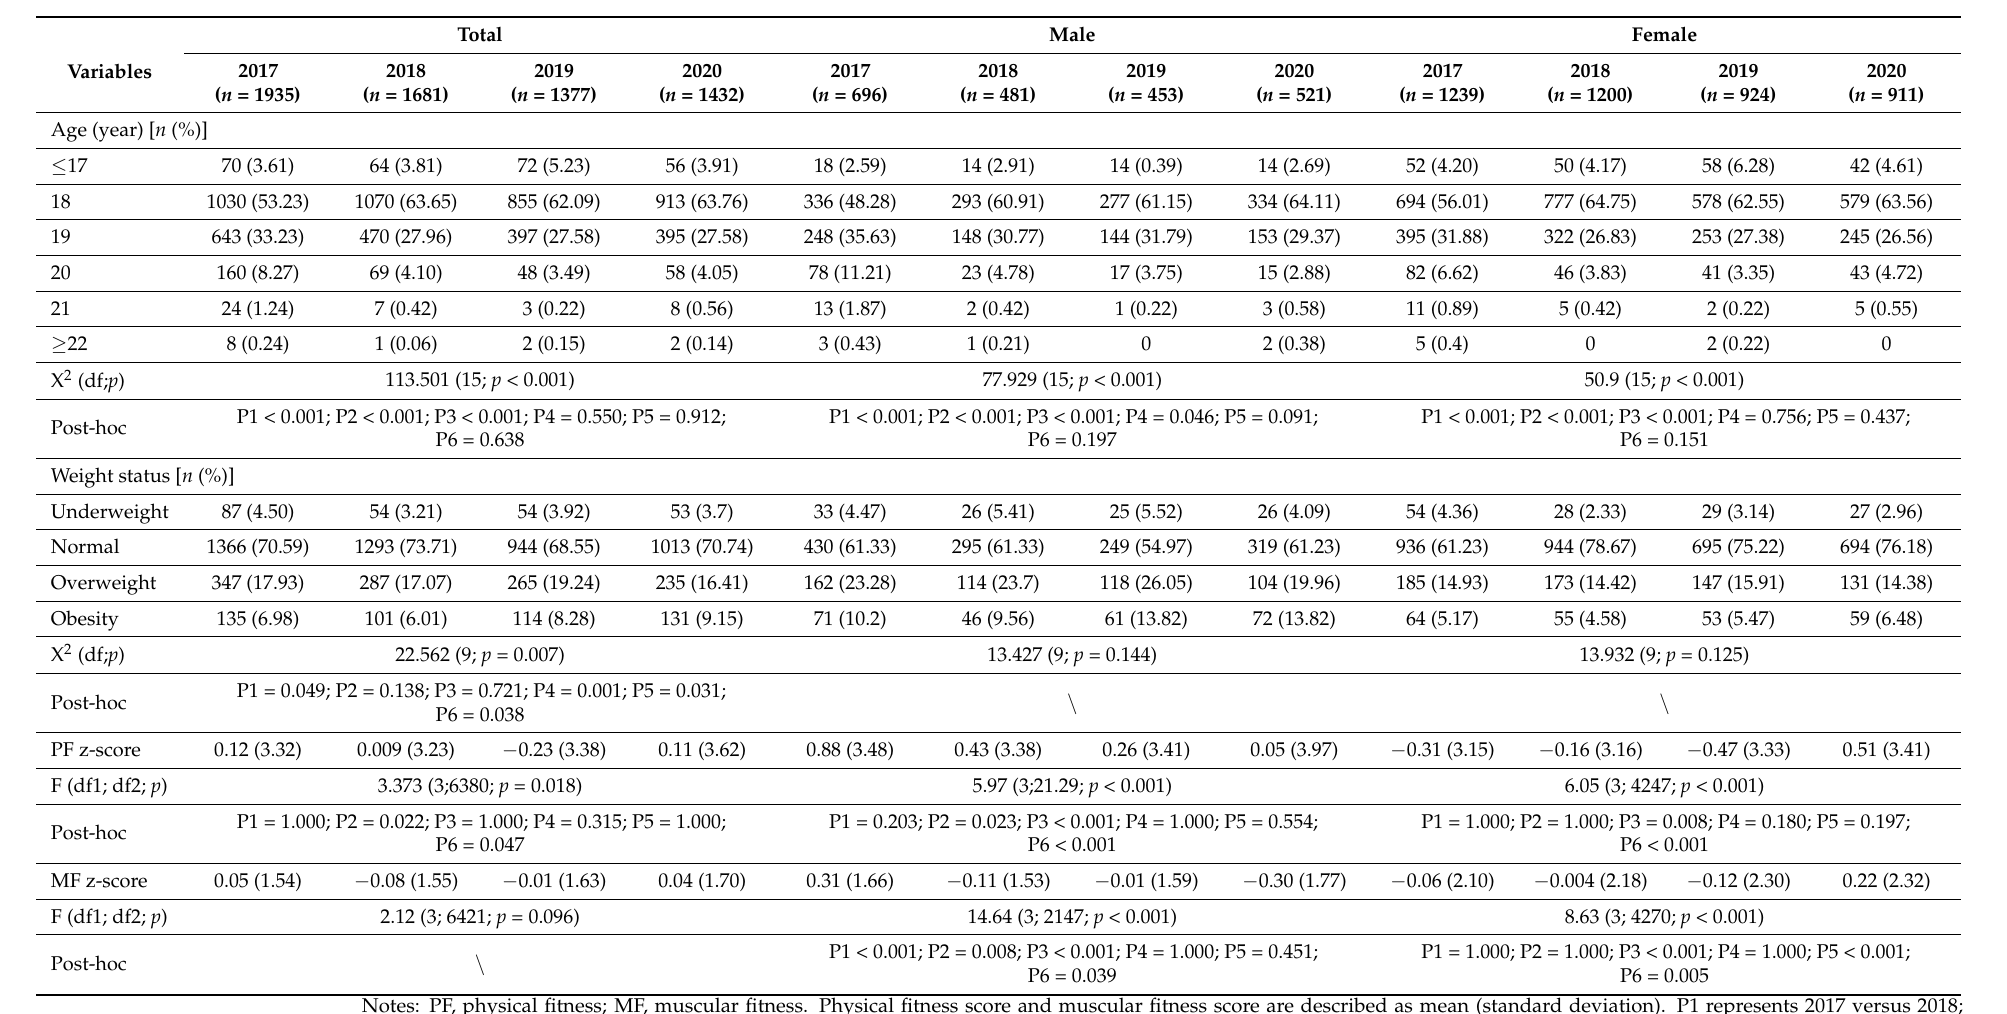
Table 1. The basic characteristics of